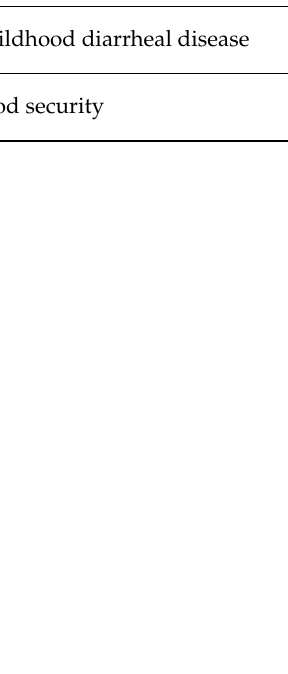
Figure 3. Community readiness results for ( a ) reducing childhood diarrheal diseases and ( b ) improving food security that show the full range of scores across each dimension (Median plus minimum and maximum scores).